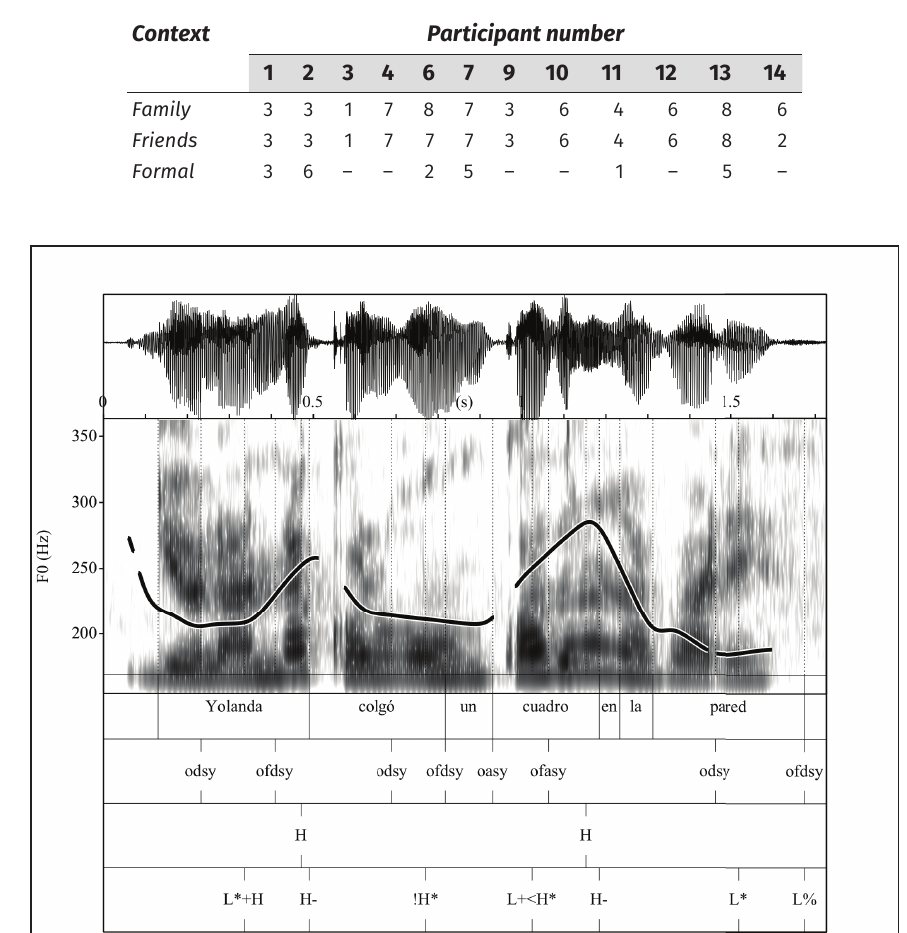
Figure 3: Example of the coding on the utterance Yolanda colgó un cuadro en la pared ‘Yolanda hung a frame on the wall’ as produced by participant 13.